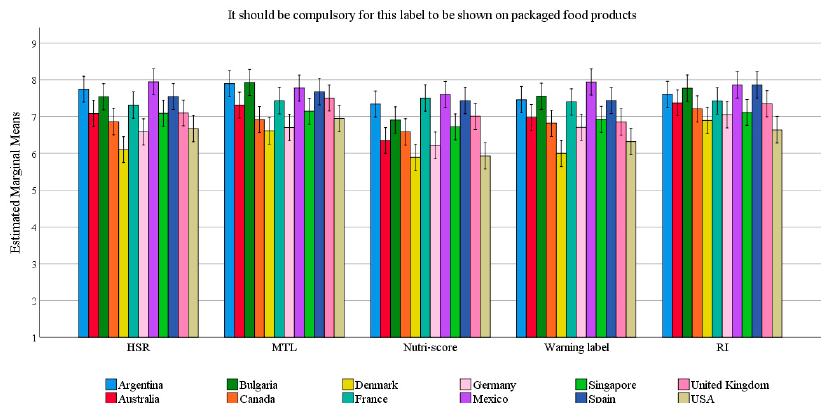
Figure 3. Mean scores across perception items according to country and FoPL type. Note: Graphs show estimated marginal means for countries adjusted for age, gender, SES, grocery buyer status, level of education, diet and nutrition knowledge. Error bars show 99% confidence intervals.